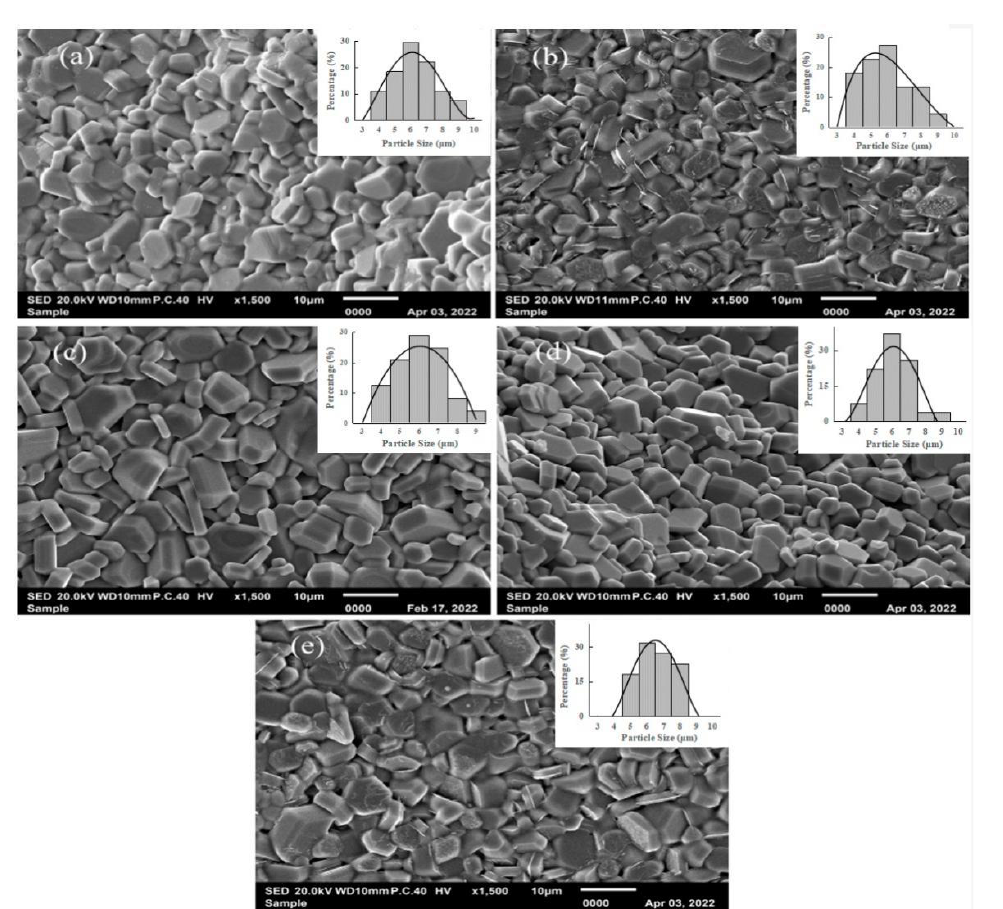
Figure 4. Typical SEM images of Sr 0.1 Ca 0.4 La 0.5 Fe 12 O 19 specimens with different precursors: ( a ) Co-, ( b ) Ni-, ( c ) Cu-, ( d ) Zn-, and ( e ) Mg-type.